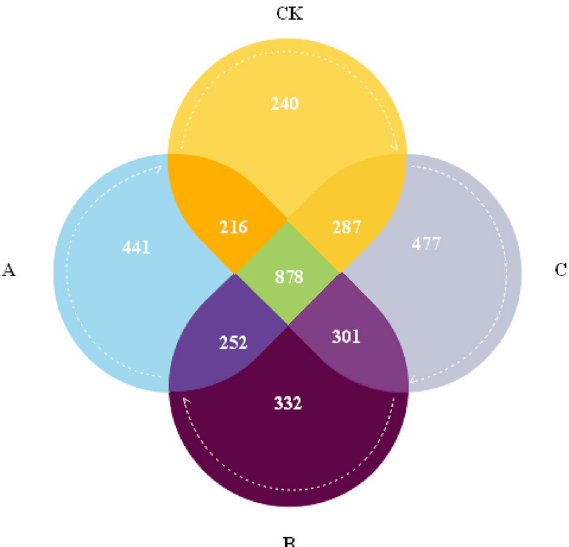
Figure 3. OTUs number of bacterial communities in each treatment. Using BMGE1.12 software (https:// bioweb. paste ur. fr/ packa ges/ pack@ BMGE@1. 12) to create.